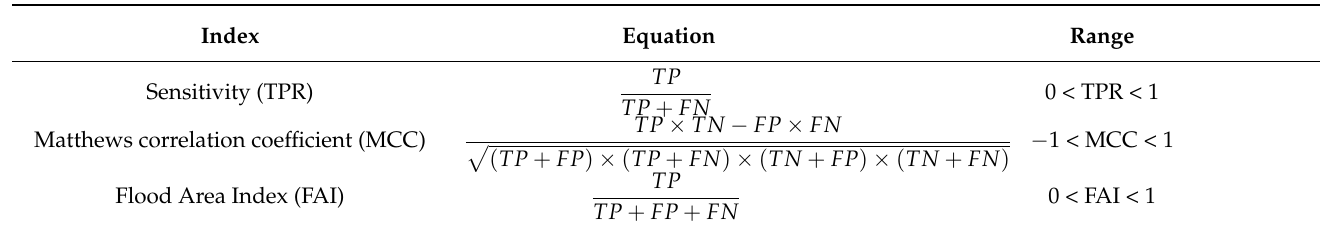
Table 1. Performance